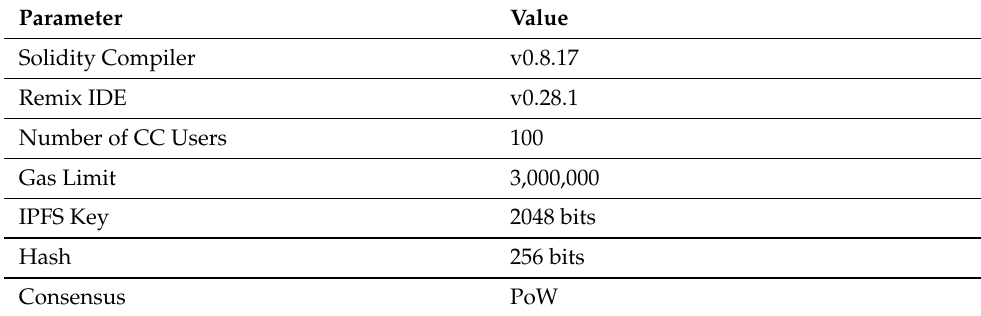
Table 3. BC and SC